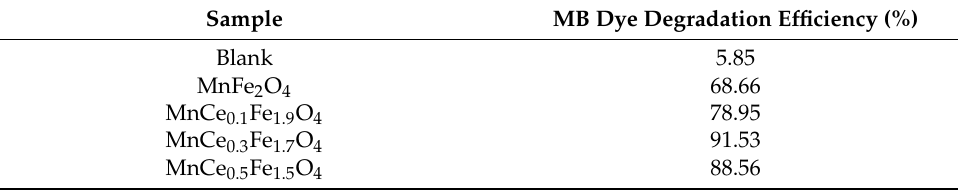
Figure 8. MB dye degradation using spinel MnCe x Fe 2 − x O 4 (x = 0.0, 0.1, 0.3 and 0.5) NCs. Table 3. Percentage of PCD of MB on to spinel MnCe x Fe 2 − x O 4 (x = 0.0, 0.1, 0.3 and 0.5)